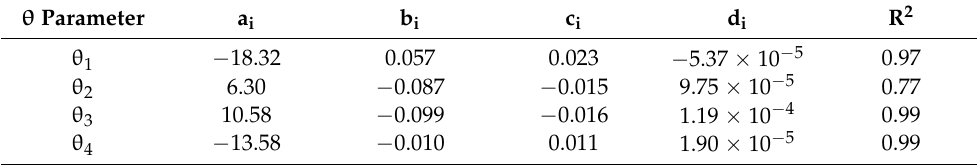
Table 4. Material constants corresponding to each θ i parameter for MarM247LC superalloy. θ